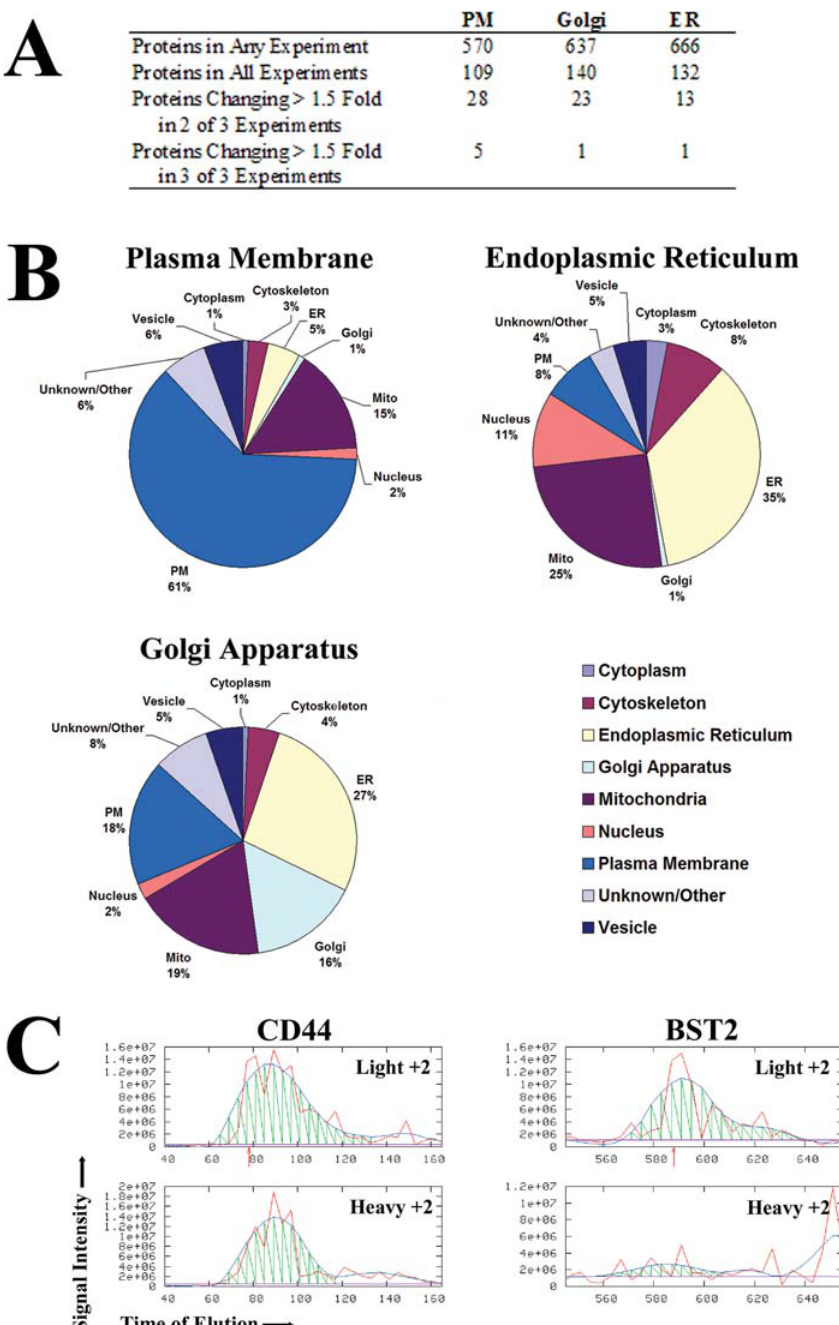
Figure 2. Protein Identification and Differential Peptide Quantification (A) Approximately 500–700 proteins were identified by at least one peptide in each fraction; however, fewer than 150 proteins per fraction were identified in all three replicates. Of these, only five proteins changed more than 1.5-fold in the plasma membrane (PM) fraction, while only one protein changed more than 1.5-fold in all three replicates of either the Golgi or ER fractions. (B) Proteins present in all three replicates of each fraction were analyzed for their predicted subcellular distribution using annotations in the Swiss-Prot proteomics database. (C) Comparison of signal intensities obtained for selected peptides from the indicated proteins. The red line indicates the actual raw data recovered from the mass spectrometer; the blue line is a hypothetical best fit line drawn to help analyze elution time of the light and heavy peptides. The orange arrows indicate the time at which the initial MS/MS scan was initiated. Peptides derived from unaffected proteins, such as CD44, display a similar intensity for both the light and heavy isotopes. Peptides derived from differentially expressed proteins, such as BST-2, show clearly different intensity peaks for the light and heavy peptides. Note the slightly different scale for intensity of each peptide. DOI: 10.1371/journal.ppat.0020107.g002